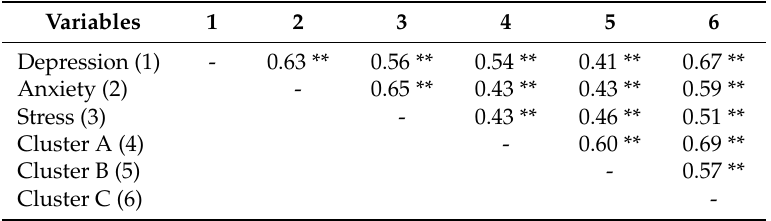
Table 3. Bivariate Pearson correlations between variables among users of an account on Facebook and on Twitter (n =